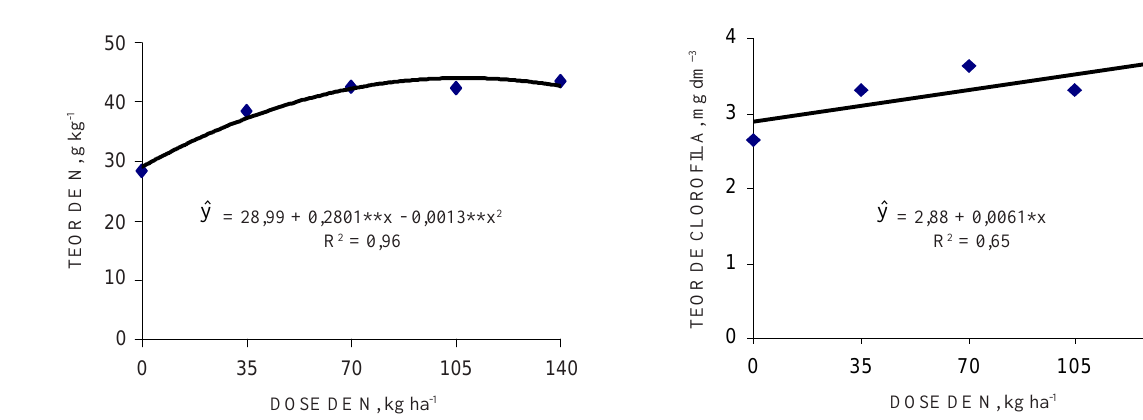
Figura 1. Teor de nitrogênio nas folhas de feijoeiro, no florescimento pleno, em função da dose de nitrogênio. ** significativo a 1%, pelo teste F.